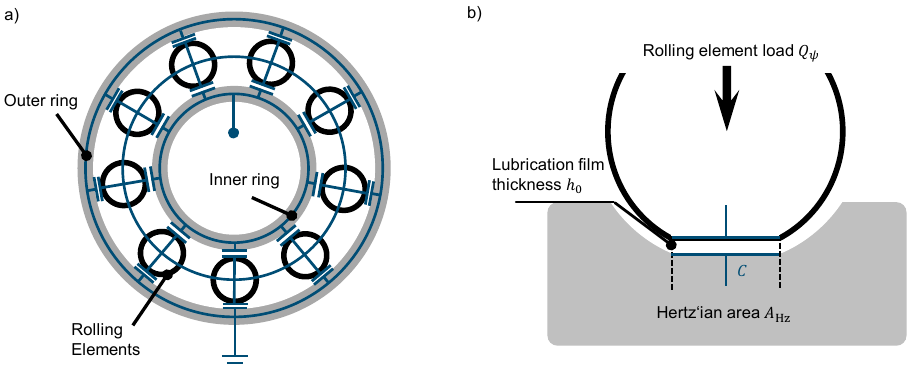
Figure 4. ( a ) Rolling bearing as a capacitor network; ( b ) Hertz’ian contact area modeled as an electric capacitance, c.f. [30,39].